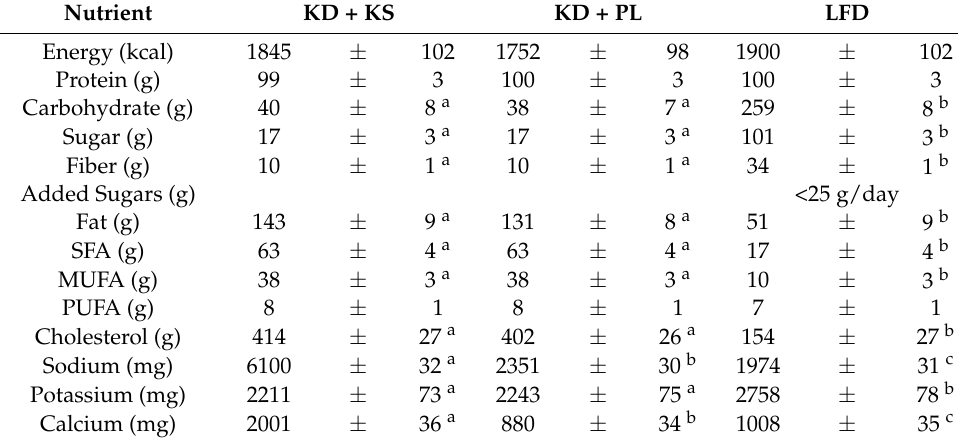
Table 2. Diet composition.